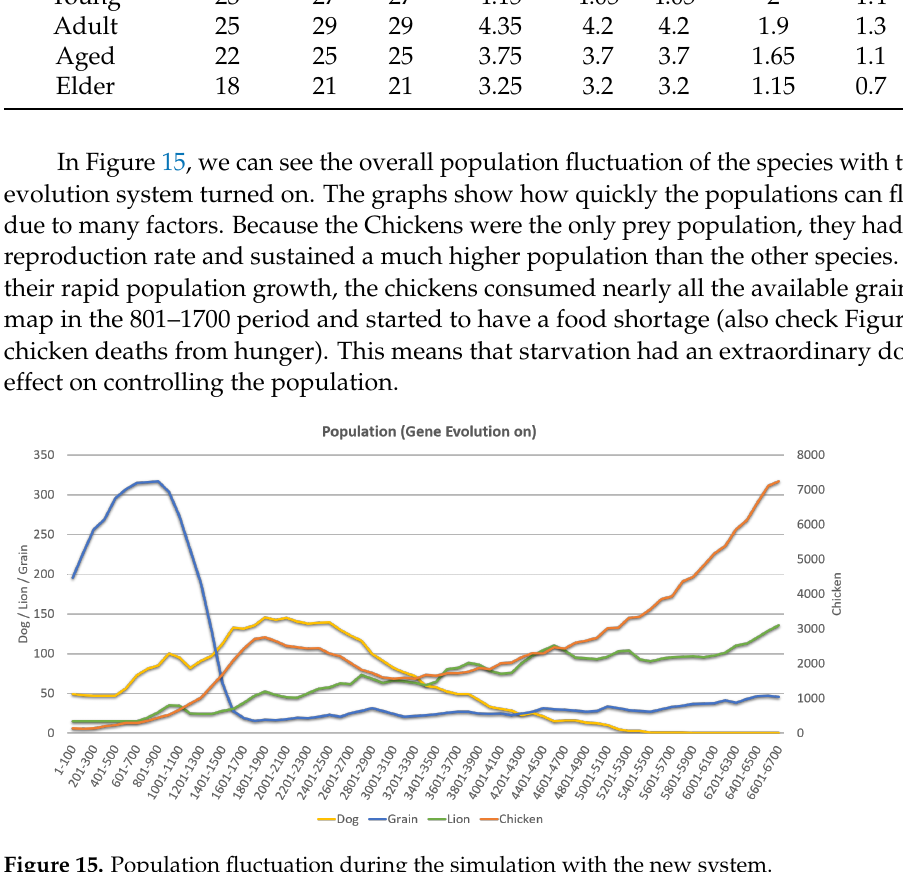
Figure 15. Population fluctuation during the simulation with the new system.